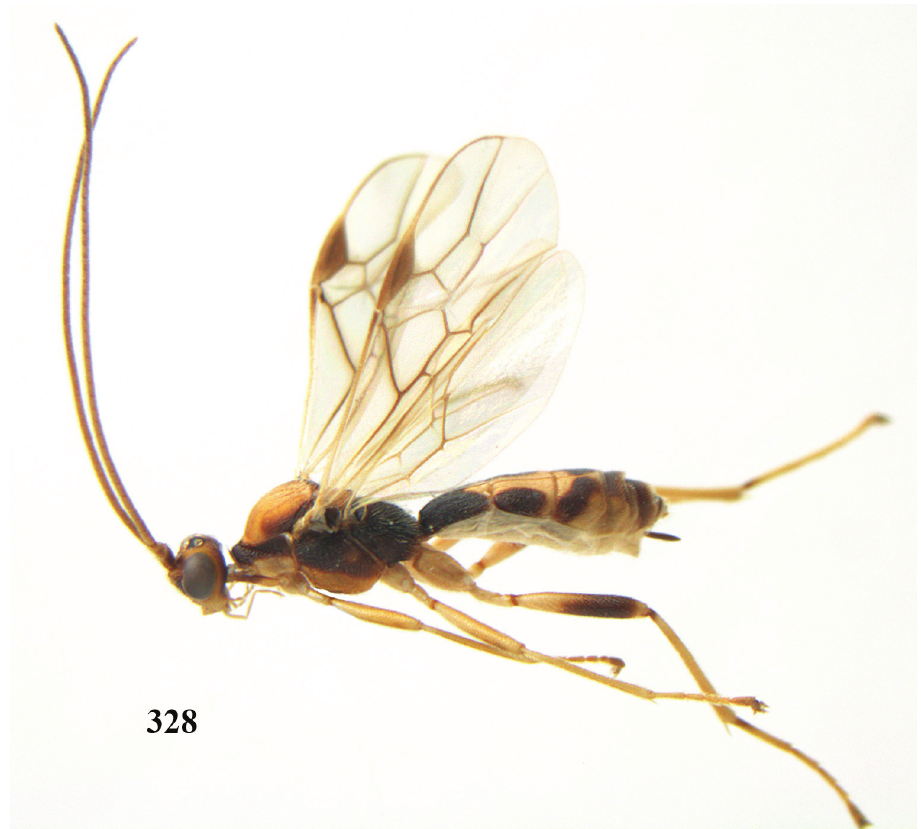
Figure 328. Aleiodes seriatus (Herrich-Schäffer) s.l., ♀ , Netherlands, Wijster, habitus lateral. Diagnosis. Antennal segments of ♀ (35–)44–50, of ♂ (42–)48–53; length of malar space of ♀ 0.3–0.4 × (of ♂ 0.25 times) height of eye in lateral view (Fig. 338); OOL 0.8 × diameter of posterior ocellus; temple narrow (Fig. 339); surroundings of veins 1-M and 1-SR of fore wing more or less infuscate (Fig. 329); inner apex of hind tibia with comb (Fig. 340); metasoma of ♀ maculate (Fig. 331; less so in males); fourth tergite of ♀ pale (ivory) yellowish latero-posteriorly, in ♂ usually infuscate or this tergite uniformly pale brown; base of hind tibia usually narrowly dark brown; length of hind femur of ♀ 5.1–6.5 × its width (of ♂ up to 8 x); fourth tergite gently folded laterally, without acute lateral crease or this only anteriorly developed, al- though rarely present as a simple, non-lamelliform crease to apex of tergite; precoxal area, epicnemial area and propodeum laterally, rugose; fourth tergite superficially transversely rugulose or aciculate; setose part of ovipositor sheath 0.6 × as long as hind basitarsus. The patterning of the metasoma is characteristic but very variable in extent (Figs 328,